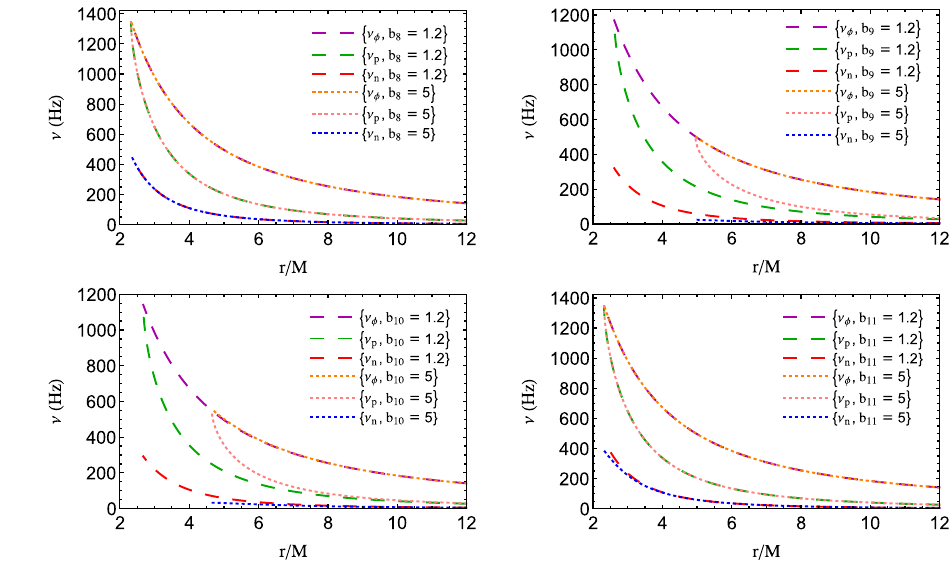
case equal to 1. In each panel, purple long-dashed, green short-dotted, and red dotted lines show ν φ , ν p , and ν n for case b i = 1 . 2, respectively. The purple, green, and red solid lines show ν φ , ν p , and ν n for case b i = 1 . 2, respectively. The mass and dimensionless spin parameter of the black hole are fixed at 5 . 4 M (cid:2) and 0 . 9 i in each